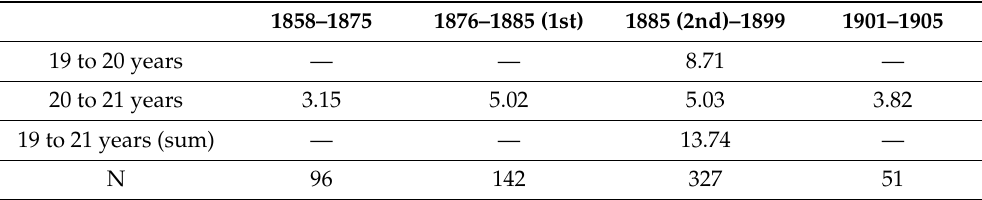
Table 1. Increments in average height by age of conscription (in mm). In 1885, due to the change in the age of conscription (from 20 to 19 years), there were two